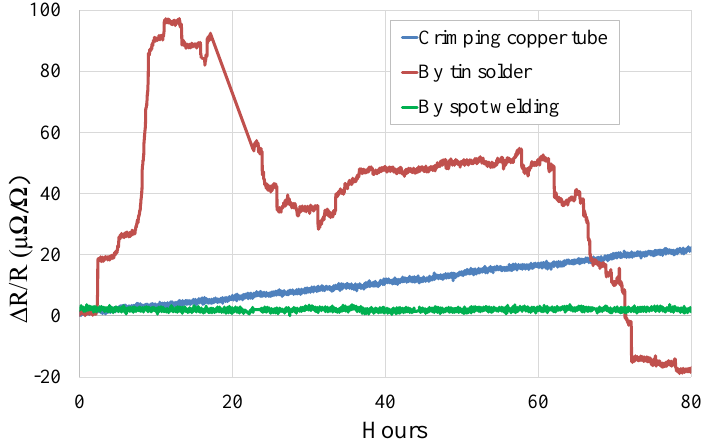
Figure 6. Graph of the stability in the measured resistance value of a 16 cm Evanohm-S wire with terminals joined through tin solder, crimped copper tube, and spot welder.